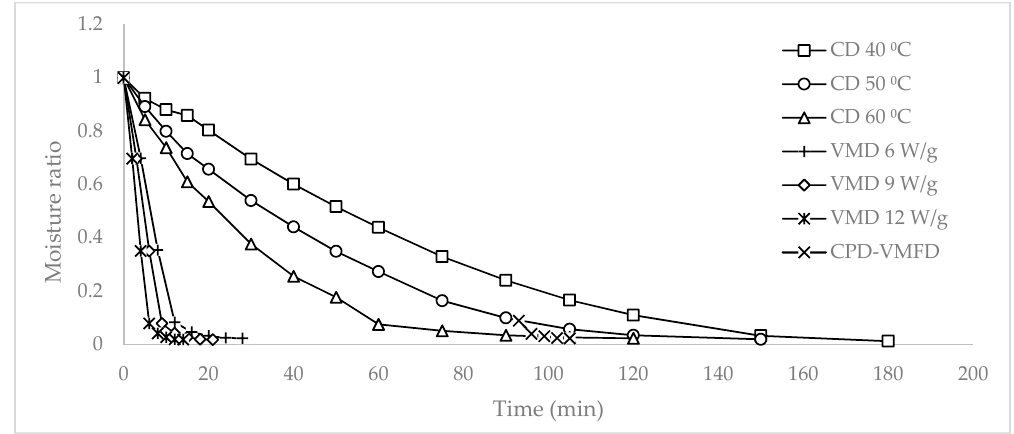
Figure 1. The relationship between moisture ratio and time for the drying of Strobilanthes crispus with convective drying (CD) at 40, 50, and 60 °C, vacuum microwave drying (VMD) at 6, 9, and 12 W/g, and convective pre-drying followed by vacuum microwave finish drying (CPD-VMFD) at 50 °C and 9 W/g.